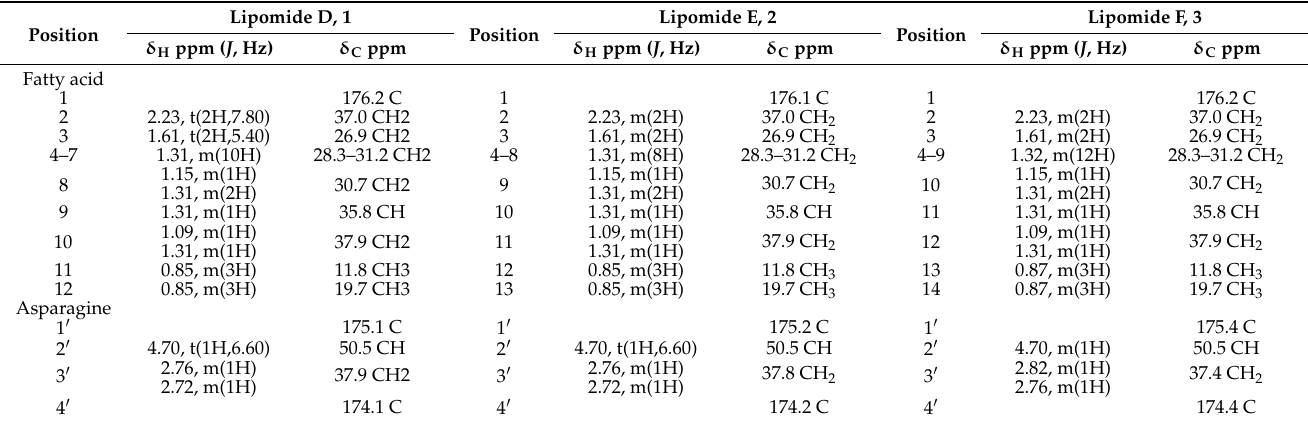
Table 1. 1 H NMR ( J in Hz), 13 C NMR spectral data of lipomide D–F, 1 – 3 , in methanol- d 4 . Lipomide D,